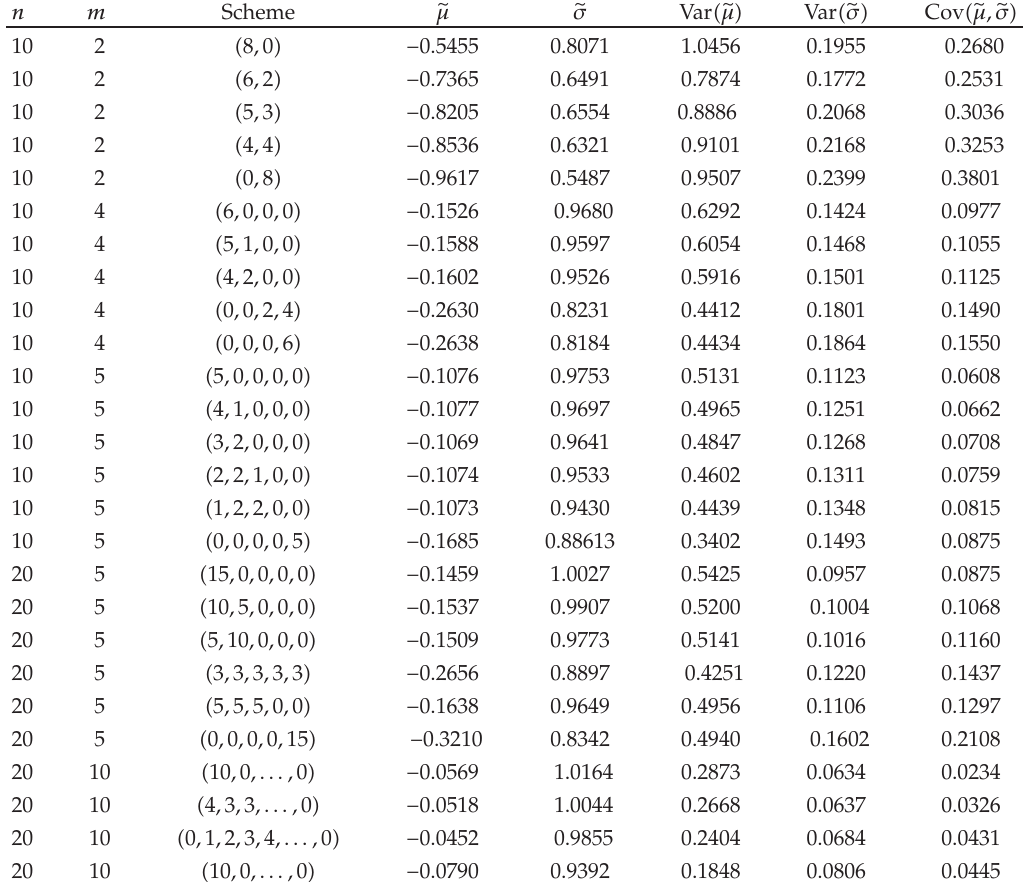
Table 3: Average, variances, and covariance of the approximate MLEs when the shape parameter φ (cid:7)